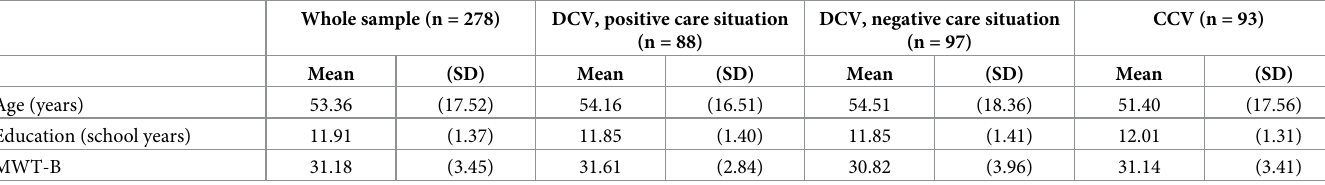
Table 1. Description of demographical data of the study sample (n =